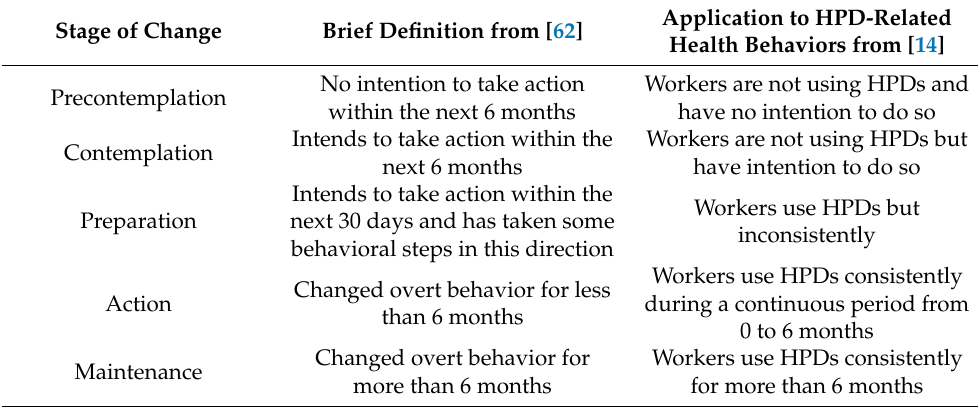
Table 6. Stages of change of the Transtheoretical